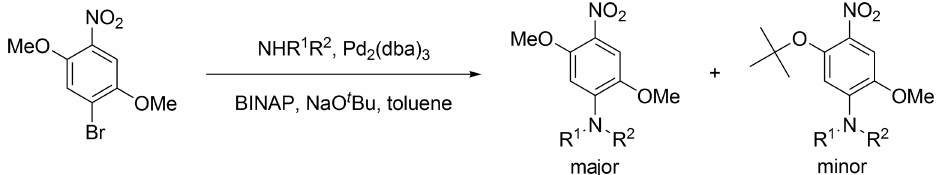
Fig 1. Identification of a byproduct from a palladium catalyzed aryl amination